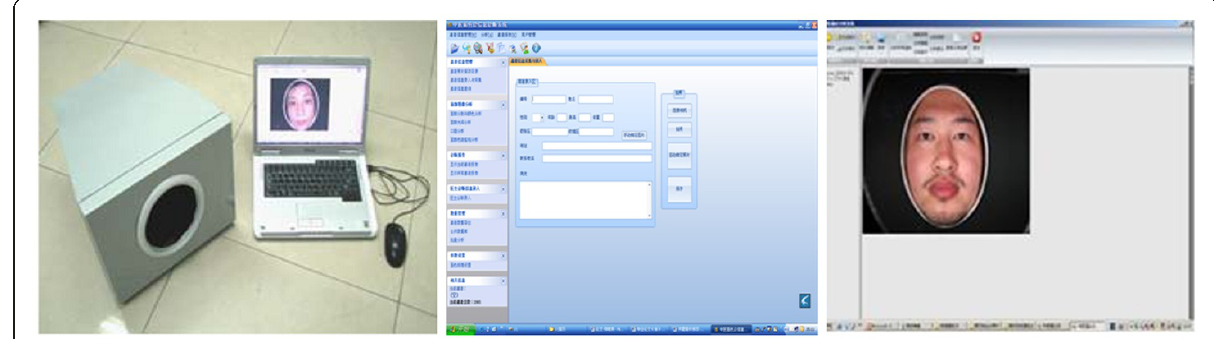
Figure 2 The face image (facial inspection) acquisition